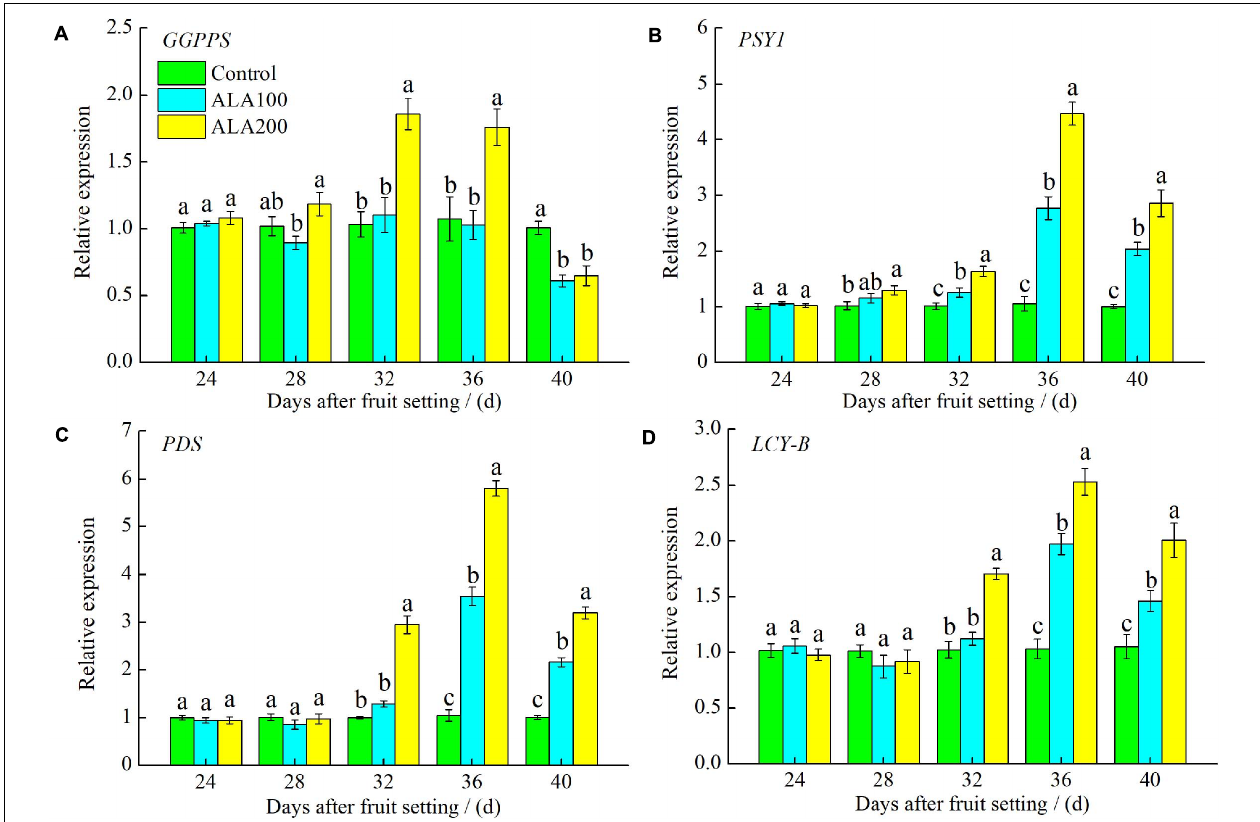
FIGURE 5 | Relative expression levels of key genes involved in lycopene synthesis and metabolism pathway. (A) Relative expression of GGPPS , encoding geranylgeranyl diphosphate synthase; (B) relative expression of PSY1 , encoding phytoene synthase; (C) relative expression of PDS , encoding phytoene desaturase; and (D) relative expression of LCY-B , encoding lycopene β -cyclase. Vertical bars represent mean ± SE from three independent replicates and the different letters denote significant differences ( p < 0.05). The control group was used as reference at each sampling time